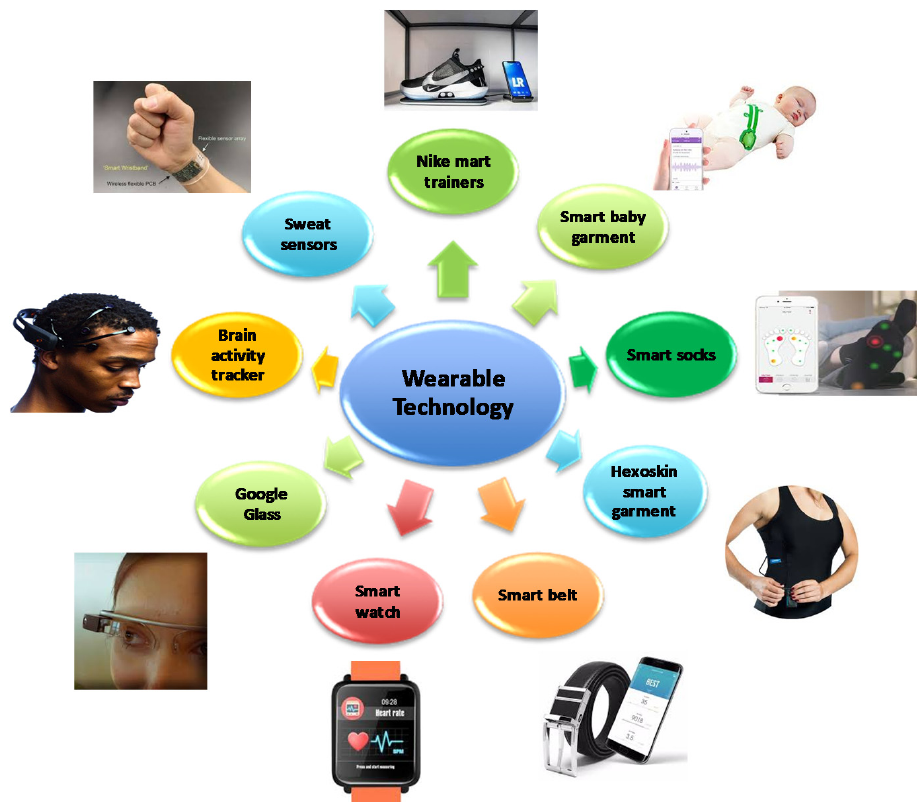
Figure 1. Examples of wearable technology.